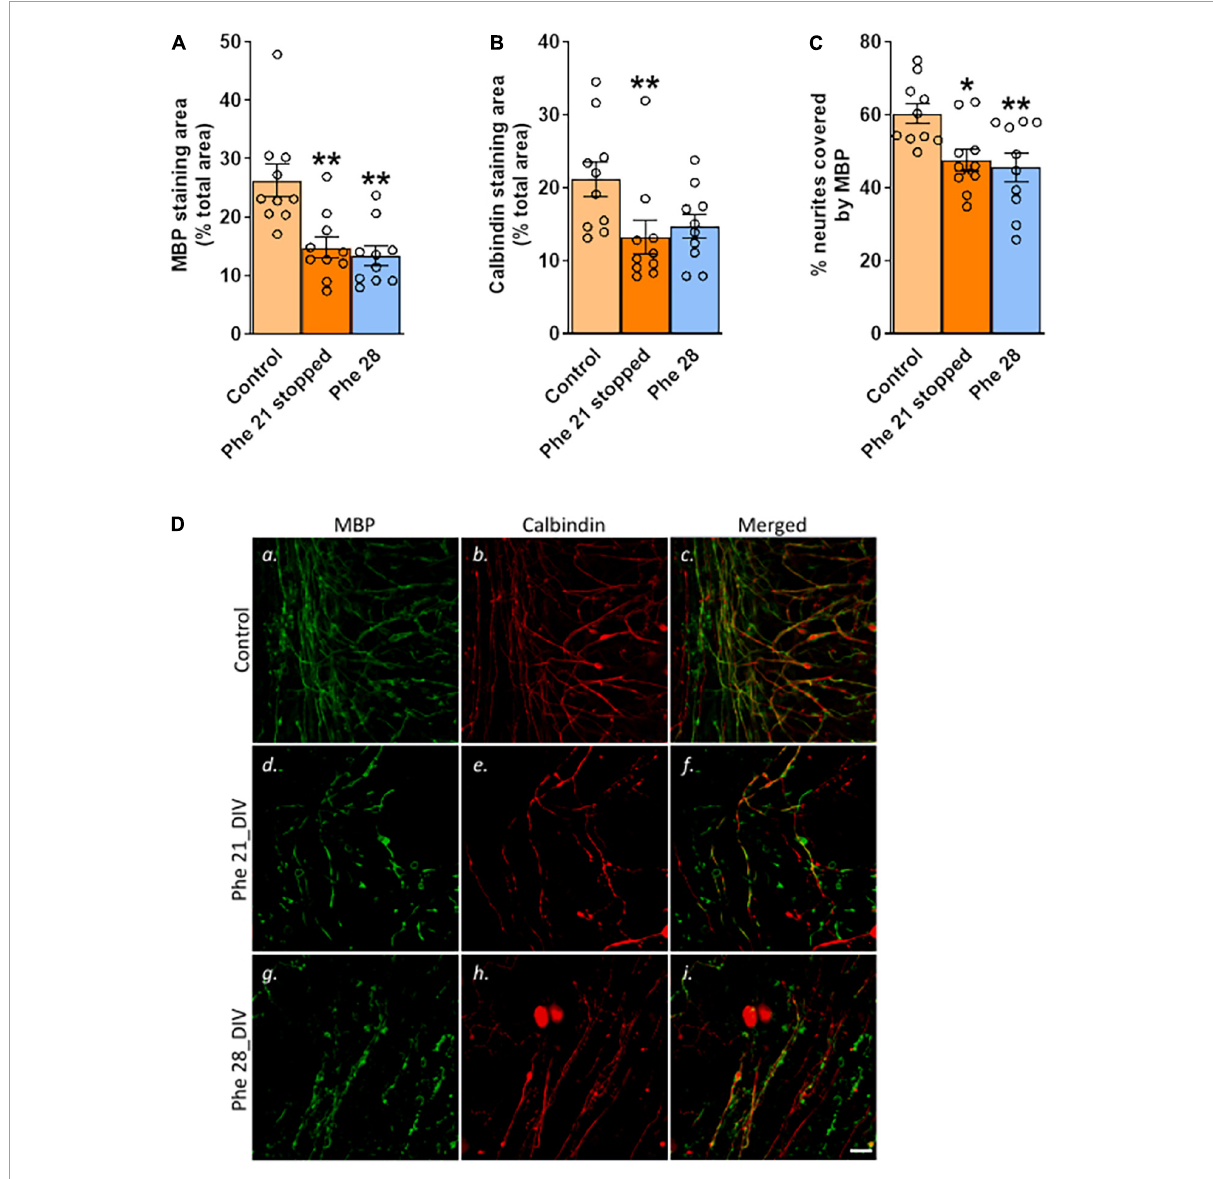
FIGURE3 Stopping high phenylalanine for 7 days after 21 DIV of exposure did not result in detectable remyelination. Cerebellar slices were incubated for 21 or 28 days in vitro (DIV) in a control medium or a medium containing phenylalanine (Phe) at 2.4 mM. At 21 DIV, the Phe-enriched medium was replaced with the control medium (0.1 mM Phe) in one of the Phe-supplemented groups (called “Phe 21 stopped”), whereas the other Phe-exposed group was kept in the Phe-enriched medium for another 7 DIV (“Phe 28”). The graphs show the results of the immunohistochemistry quantification: (A) Mean area covered by myelin basic protein (MBP) staining as % of the total area of the field of view; representative images are shown in panels ( D a,d,g); (B) Mean area covered by calbindin staining as % of the total area of the field of view; representative images are shown in panels ( D b,e,h); (C) % of neurites stained for MBP; representative images are shown in panels ( D c,f,i). Data are plotted as Mean ± SEM of N = 10 slices/group. Scale bar = 20 µ m. Statistical symbols indicate significance at ∗ P < 0.05 and ∗∗ P <